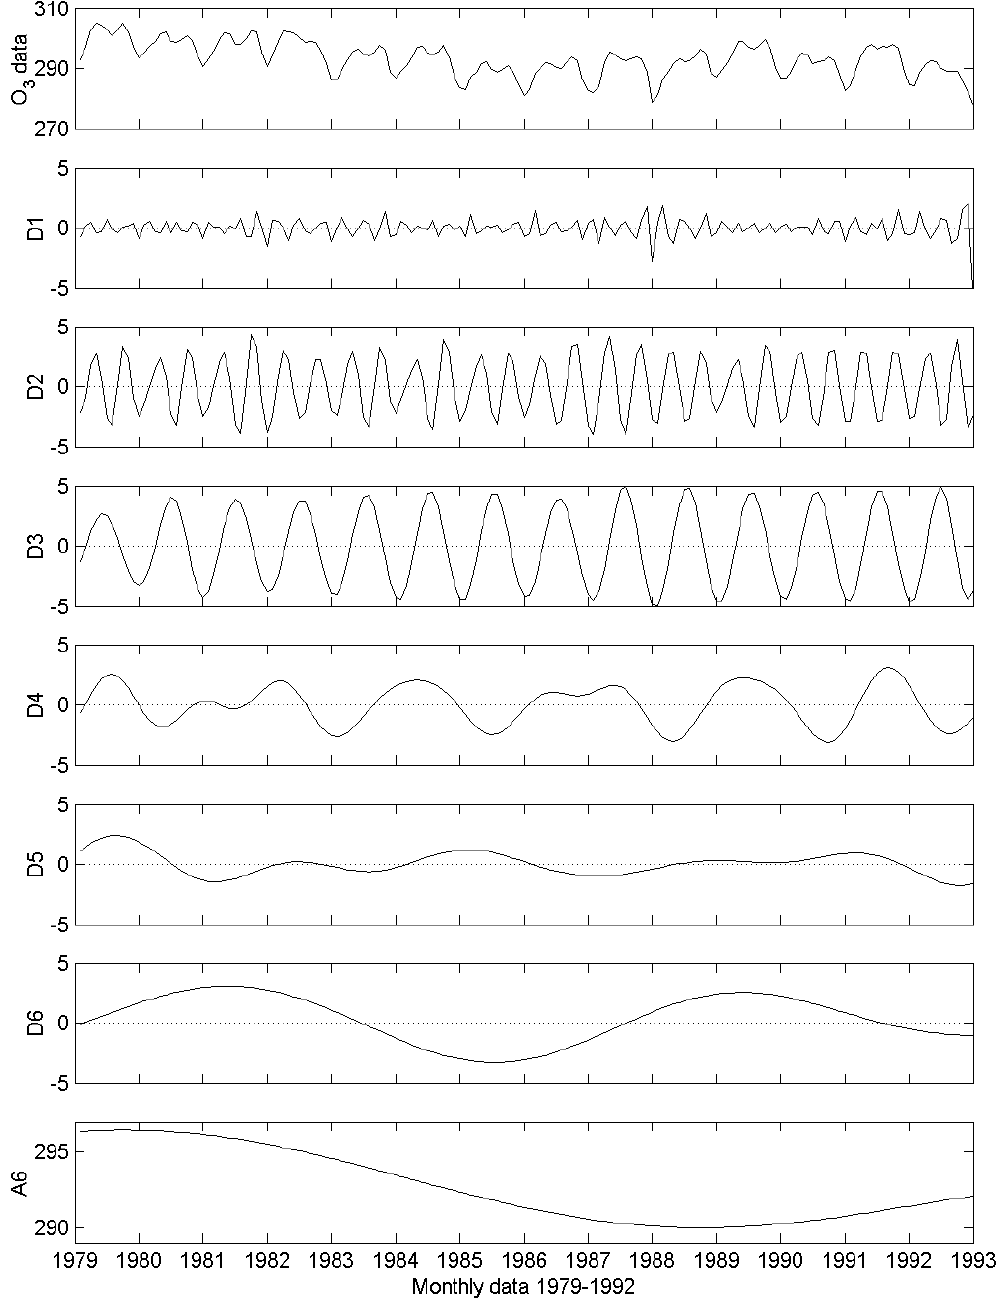
Fig. 1. Monthly averages and Meyer wavelet decomposition frequency levels for global total ozone.